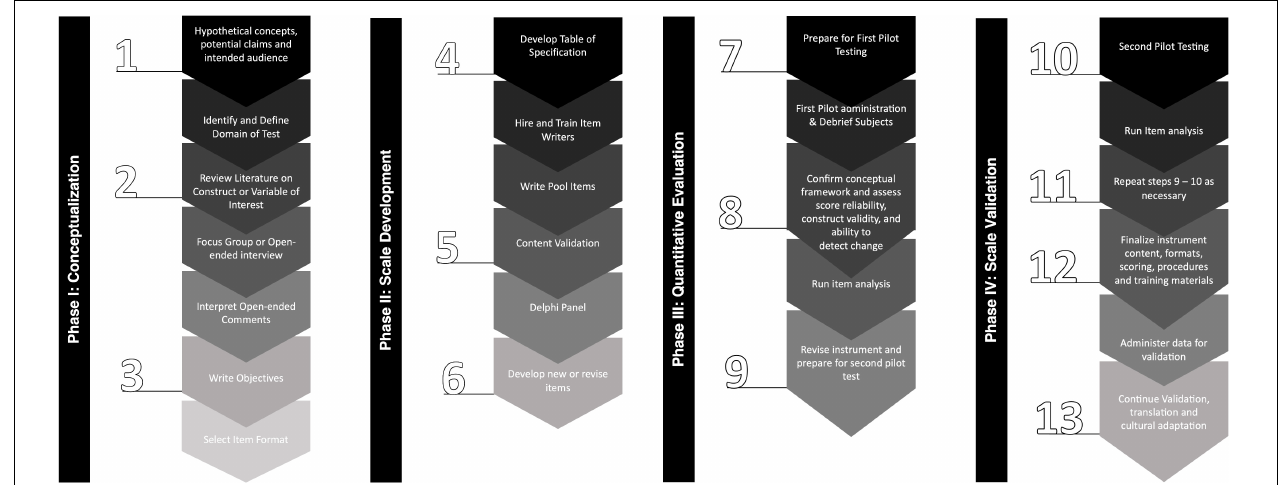
FIGURE 1 | Illustrative overview of a scale development and validation